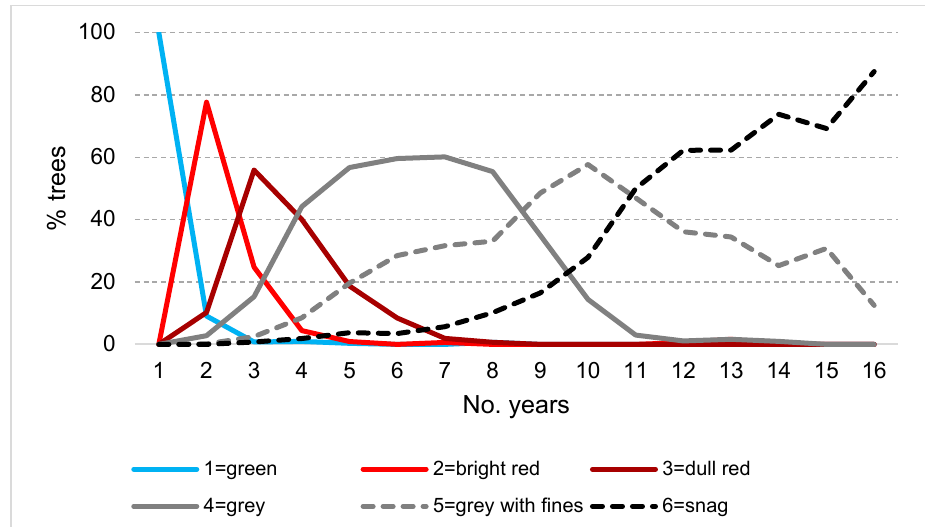
Figure 4. The percentage of D. confusus attacked subalpine fir, by phase (early-to-mid phase or mid- to-late) that contained live brood (eggs, larvae, pupae, adults) or beetle emergence after one year, two years, three years, or more than three years in seven plots.